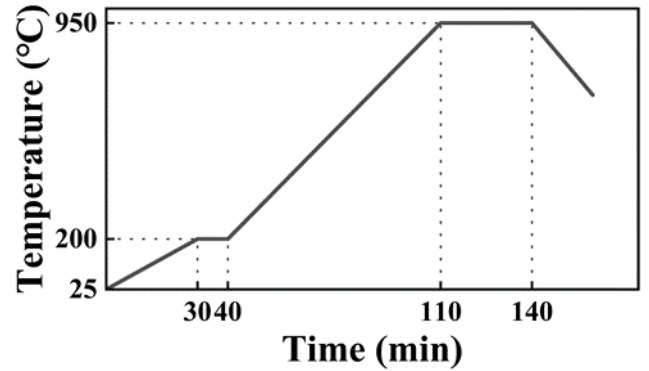
Figure 2. Heat schedule for sintering.